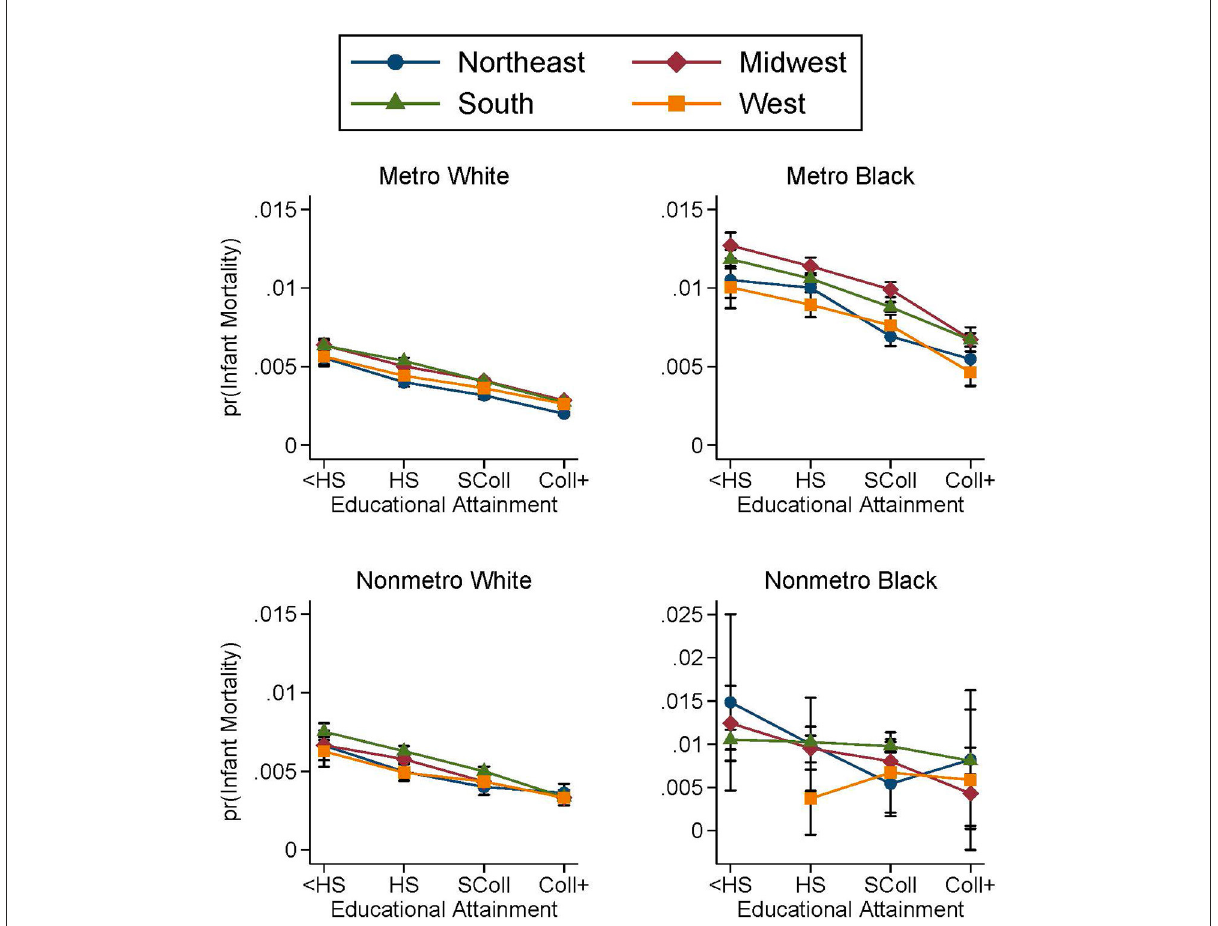
FIGURE2 Predicted probabilities of infant mortality by metropolitan residence and region for white and Black mothers, 2011–2015. Predicted probabilities are from logistic regressions controlling for mother’s age, mother’s marital status, first trimester prenatal care, child’s sex, birth order, birth year, U.S. region of birth, and mother’s county of residence’s metropolitan status as well as the complete interaction between metropolitan status, region, and educational attainment. See Supplementary Table 1 for full regression results. Births occurred between the years 2011 and 2015. Educational attainment is observed only from the revised birth certificates which had not yet been adopted by every state. The top panels plot the educational gradients of infant mortality for white and Black mothers living in metropolitan counties. The bottom panels plot the educational gradients of infant mortality for white and Black mothers living in nonmetropolitan